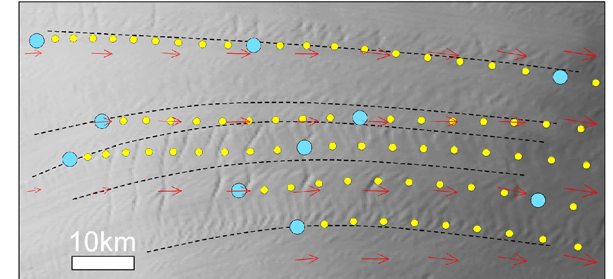
Fig. 11. Zoom-in of streamlines calculated from the 2006–2009 displacement measurements. Yellow dots are separated by 10 years of displacement and blue dots by 100 years of displacement. The black lines mark the flowlines.